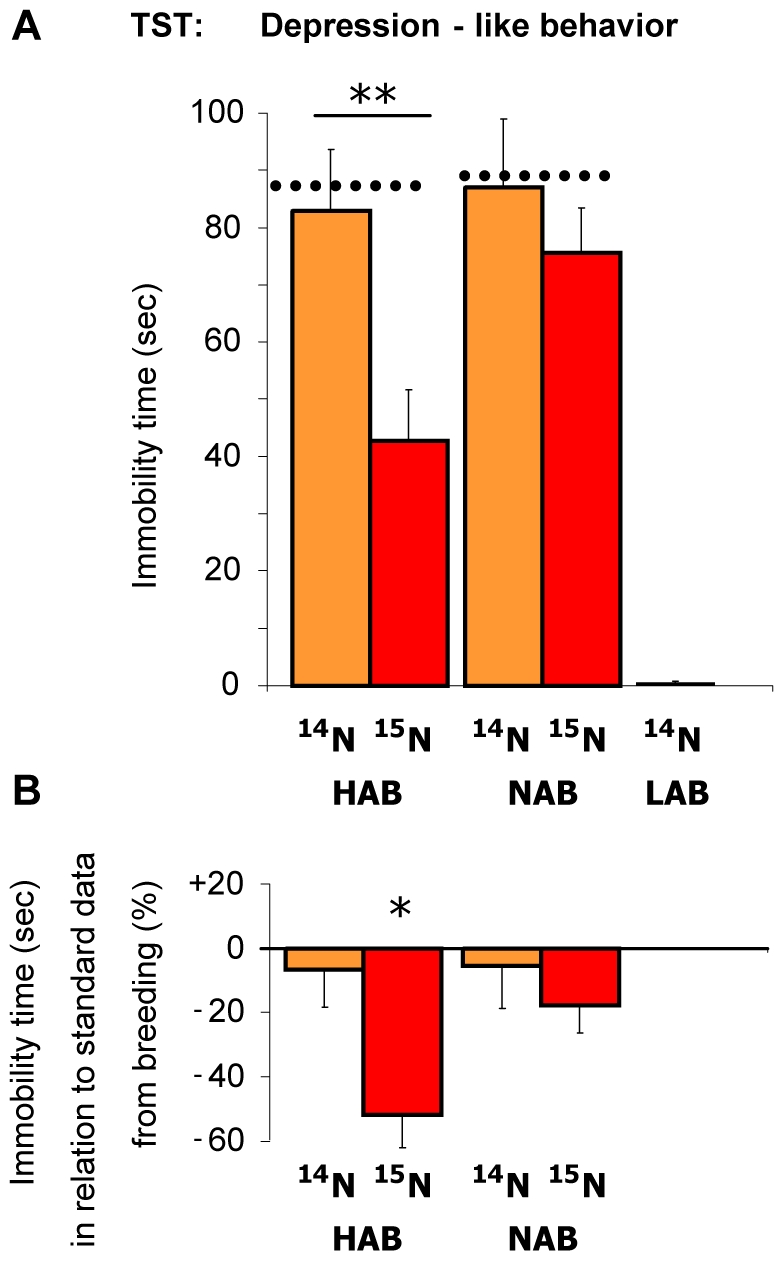
Depression-like behavior in the tail suspension test (TST).High (HAB), normal (NAB) and low (LAB) anxious animals were fed with 14N and/or 15N enriched bacteria diets. A) No behavioral changes due to diet per se were found for animals fed with bacteria diet compared to the animals of the respective lines of the HAB/NAB/LAB standard breeding of the same generation (dotted lines and indicated in B) as percentage difference of the standard breeding). However, 15N fed HAB animals showed a strongly reduced immobility, indicating depression-like behavior, compared to 14N fed HABs (**p<0.01). B) This differed significantly from the standard HAB/NAB/LAB breeding (*p<0.05). Due to division by zero, no value is given for 14N fed LAB animals in relation to the standard breeding: values are 14N LAB 0.53±0.3 sec vs. standard LAB 4.06±1.5 sec.